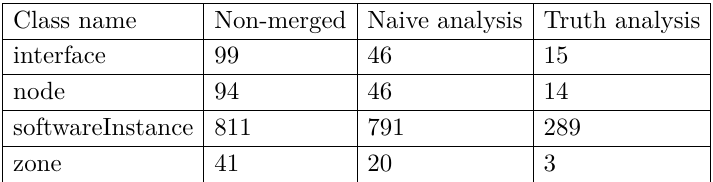
Table 10. Number of different model objects created using naive and truth analysis for the EMFTA